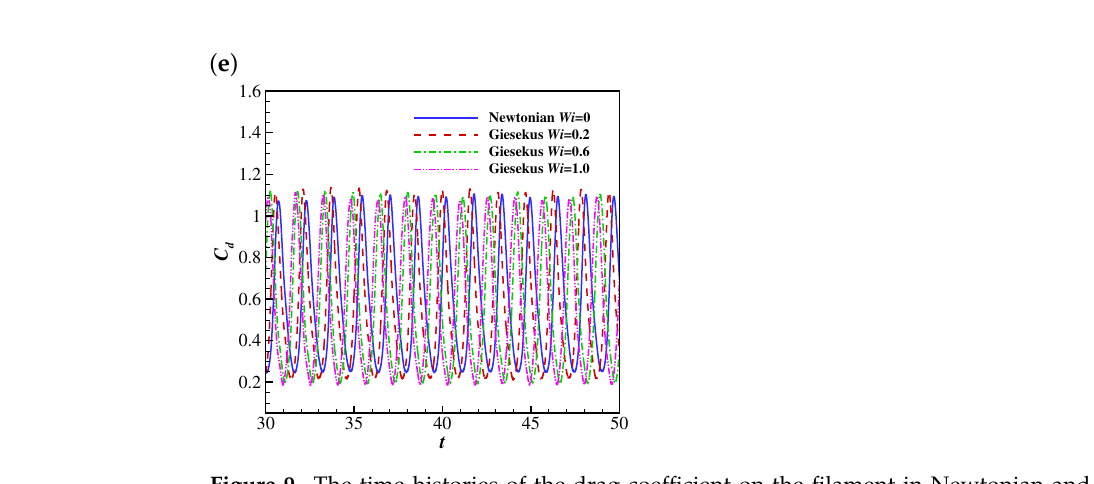
Figure 9. The time histories of the drag coefficient on the filament in Newtonian and Giesekus uniform flows at Re = ( a ) 10, ( b ) 25, ( c ) 50, ( d ) 100 and ( e ) 200. The temporal evolutions of the lift coefficient (from t = 30 to 50) on the filament are shown in Figure 12. The lift coefficient at lower Reynolds numbers (e.g., Re = 10, 25 and 50) shows oscillations with small amplitudes corresponding to the steady horizontal configuration of the filament. At Re = 100, the lift coefficient experiences damped os- cillations at Wi = 0 and 0.2 (corresponding to damped oscillations of the filament) and stable oscillations at Wi = 0.6 and 1.0 (corresponding to stable oscillations of the filament). The mechanism behind this is similar to that of the drag coefficient (the increase of the pressure difference across the filament leads to a larger lift force). Similarly to the drag coefficient, the lift coefficient also shows stable oscillations with similar amplitudes at all Wi at Re = 200. This means the lift coefficient of the filament at a sufficiently high Re (e.g., 200) is not significantly influenced by the shear-thinning property of the Giesekus fluid.